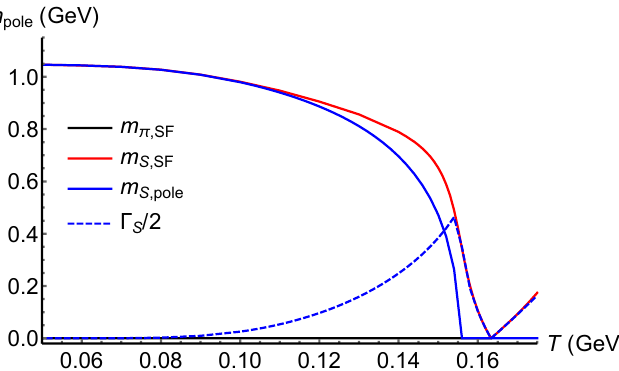
Figure 4 . The temperature dependence of the pole masses m S,pole and the thermal widths Γ S of the scalar meson in the chiral limit. Taken from ref. [91], the quasiparticle masses of the scalar meson m S,SF and the pion m π,SF , are extracted from the peak locations of the spectral functions.